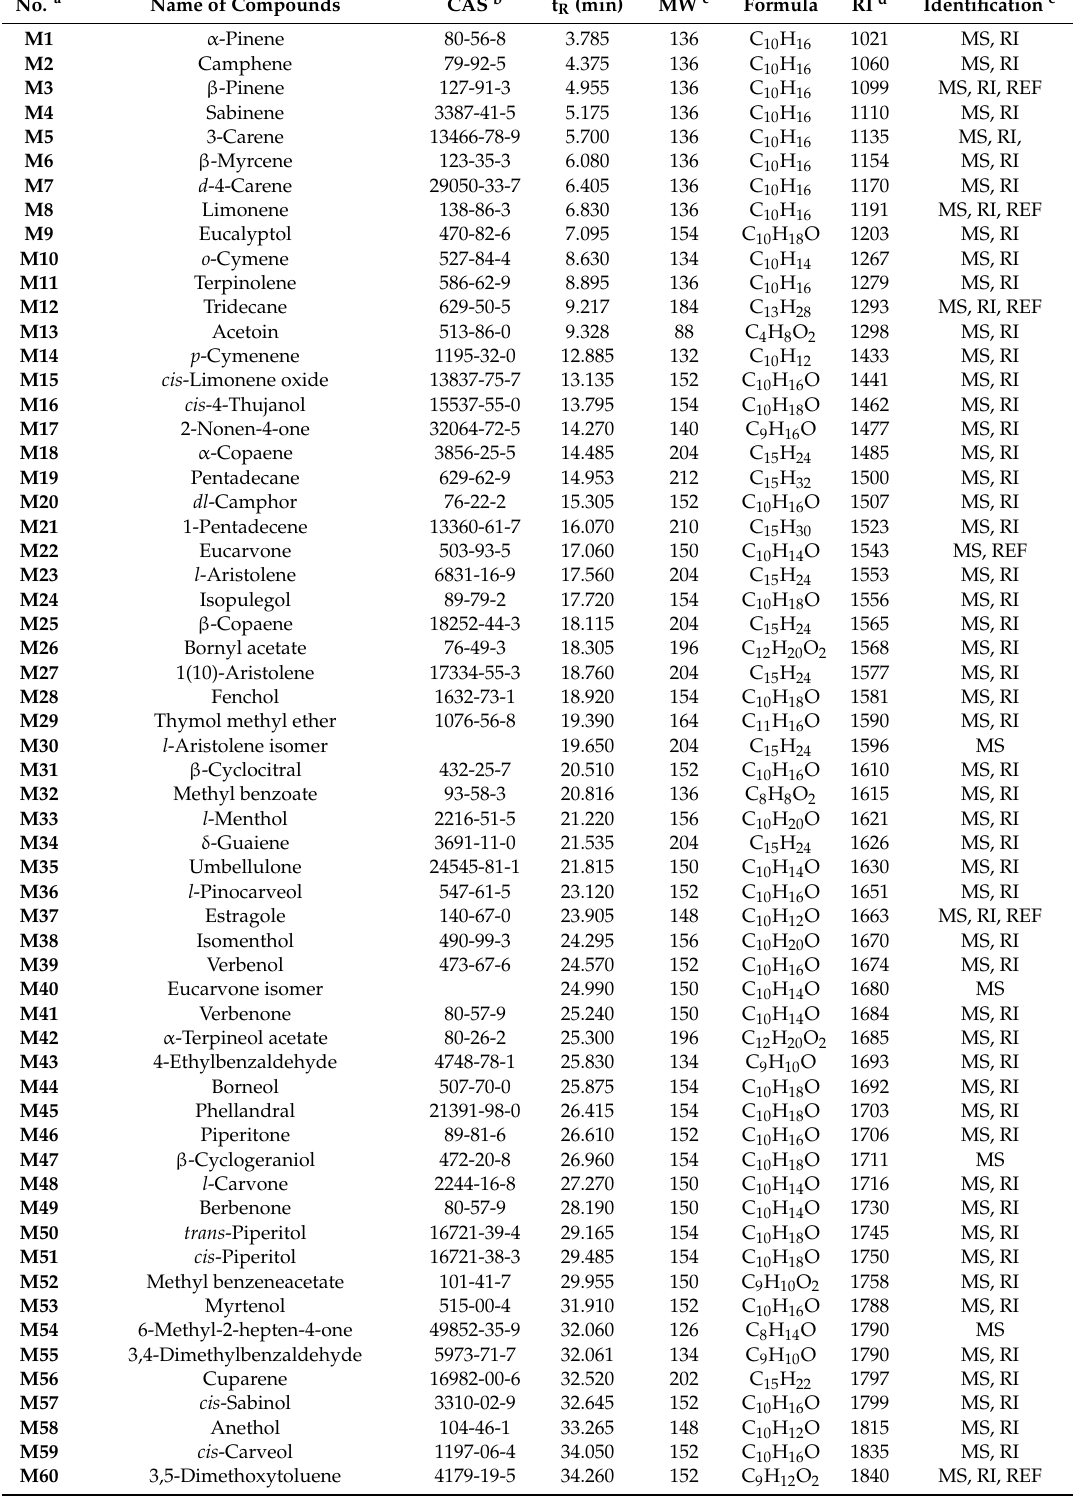
Table 1. Retention time (t R ), Chemical Abstracts Service (CAS) number, molecular formula, and identification of 153 volatile compounds in rats in vivo after oral administration of Asari Radix et Rhizoma (ARR) powder or decoction by headspace solid-phase microextraction gas chromatography mass spectrometry